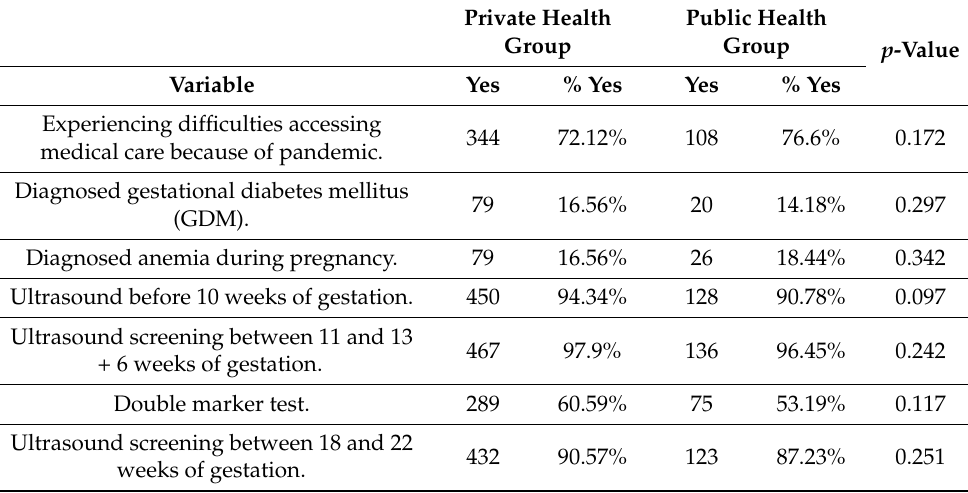
Table 3. Comparison of logical variables between private and public healthcare